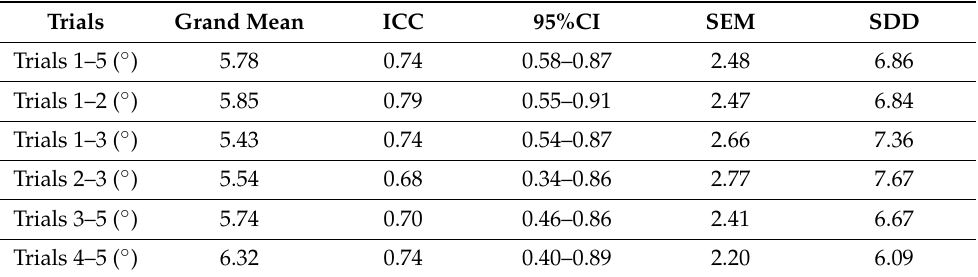
Table 2. Intra-rater reliability of the double inclinometer method for the assessment of thoracolumbar joint position sense.